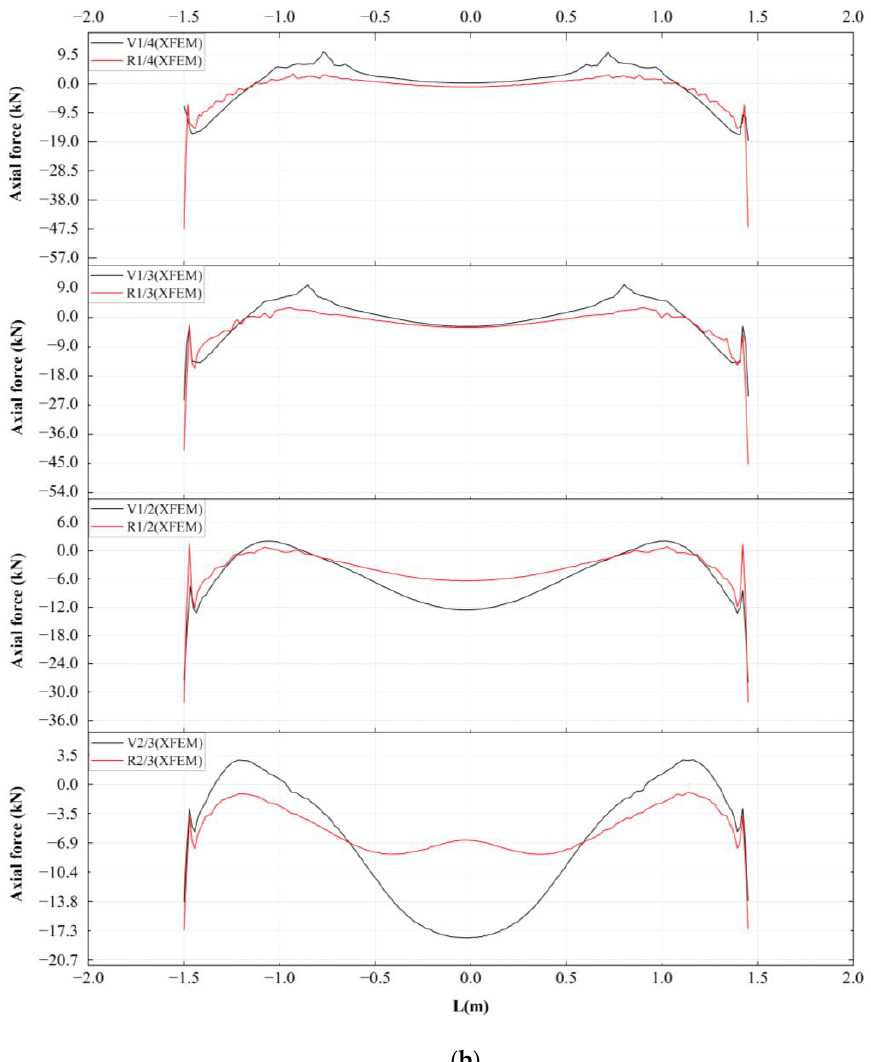
Figure 20. Stress comparison of lower rebars of strengthened and unstrengthened specimens: ( a ) CDP and ( b ) XFEM.